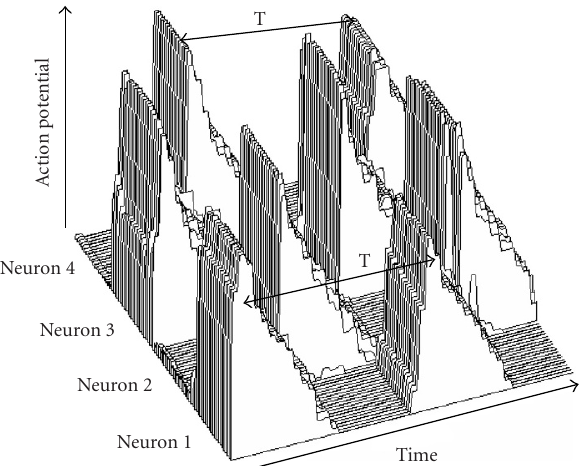
only one audio channel is available (Figure 1). It com-